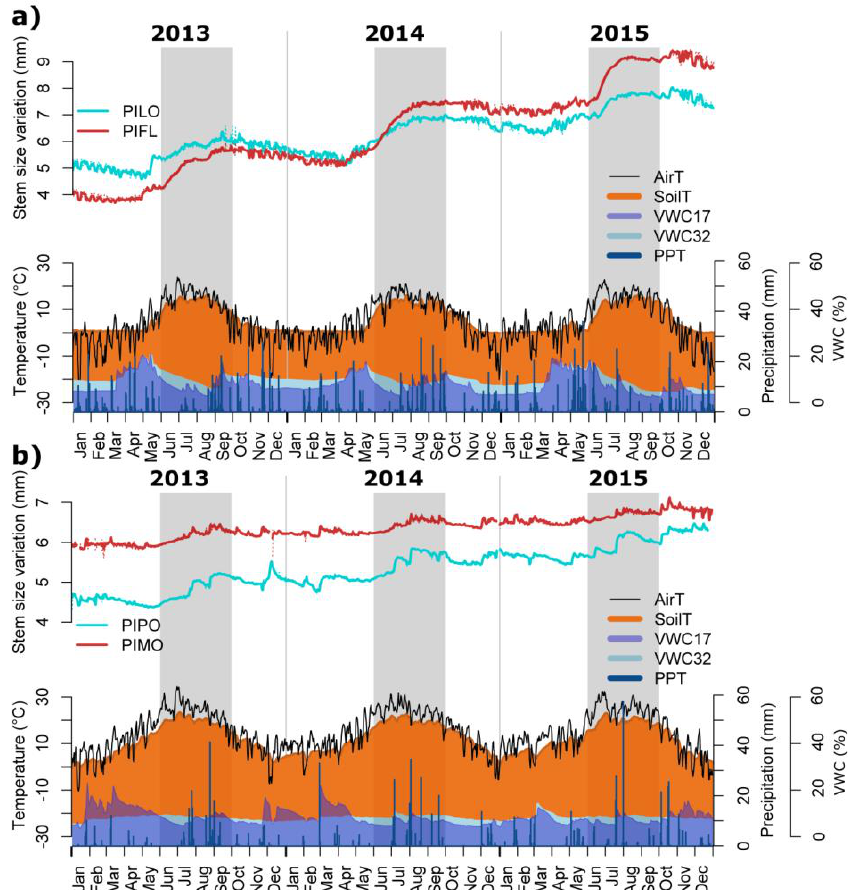
Figure 2. Site-wide composites of stem size variation during 2013 – 2015 computed for: ( a ) Pinus longaeva (PILO) and Pinus flexilis (PIFL) at the Snake Range Subalpine West site and ( b ) for Pinus ponderosa (PIPO) and Pinus monophylla (PIMO) at the Sheep Range Montane site. Daily time series of mean air temperature (AirT), soil temperature at 50 cm belowground (SoilT), volumetric water content at 2 – 17 cm (VWC 17 ) and 17 – 21 cm belowground (VWC 32 ), and total precipitation (PPT) are also shown. Gray shaded areas represent the 4-month period (June – September) considered for the analysis of circadian stem size phenology.